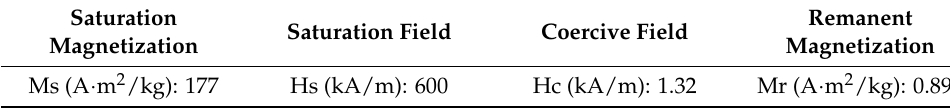
Figure 3. Magnetization curve of the micro-sized (4–6 μm) Fe particles.